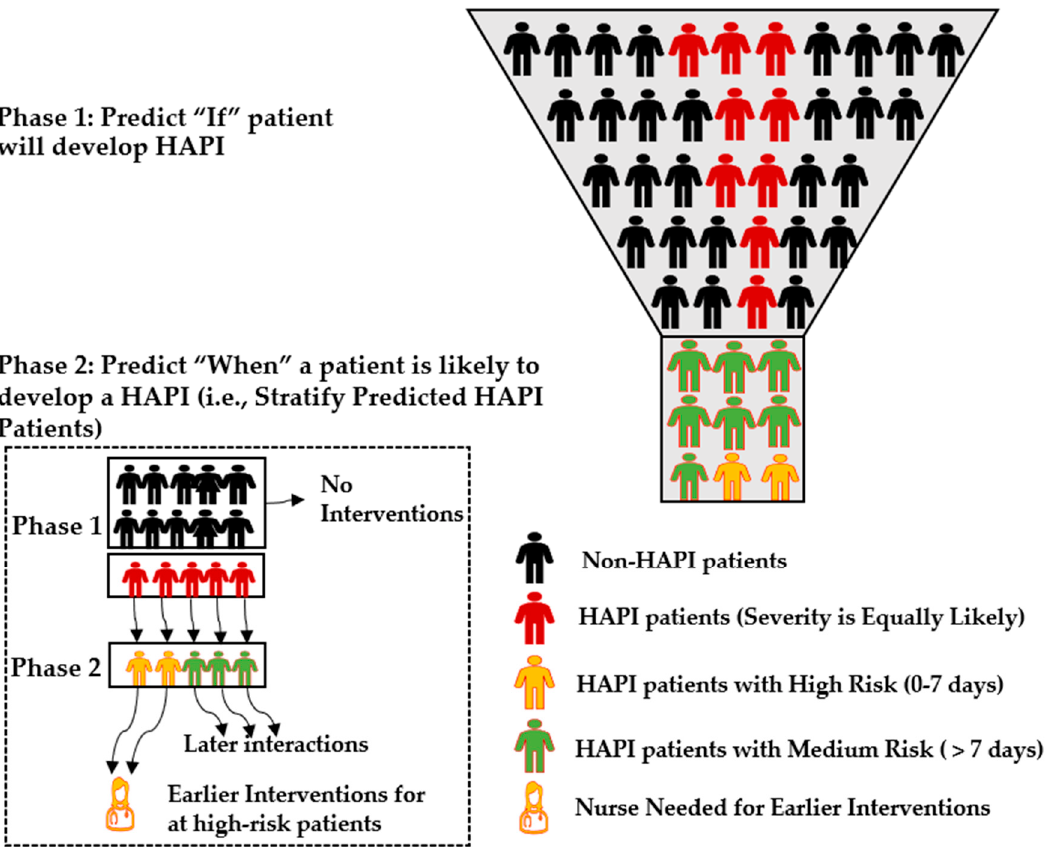
Figure 9. Implications of the proposed research on the medical team.